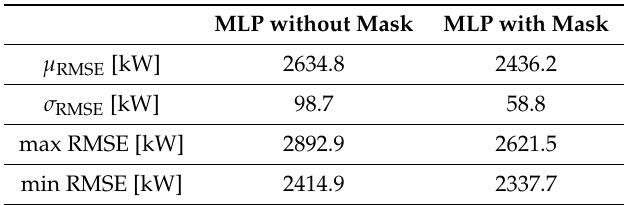
Table 2. Strategy for dealing with wind power abnormal data: forecasting performance of the trained MultiLayer Perceptrons (MLPs) with and without the proposed mask.